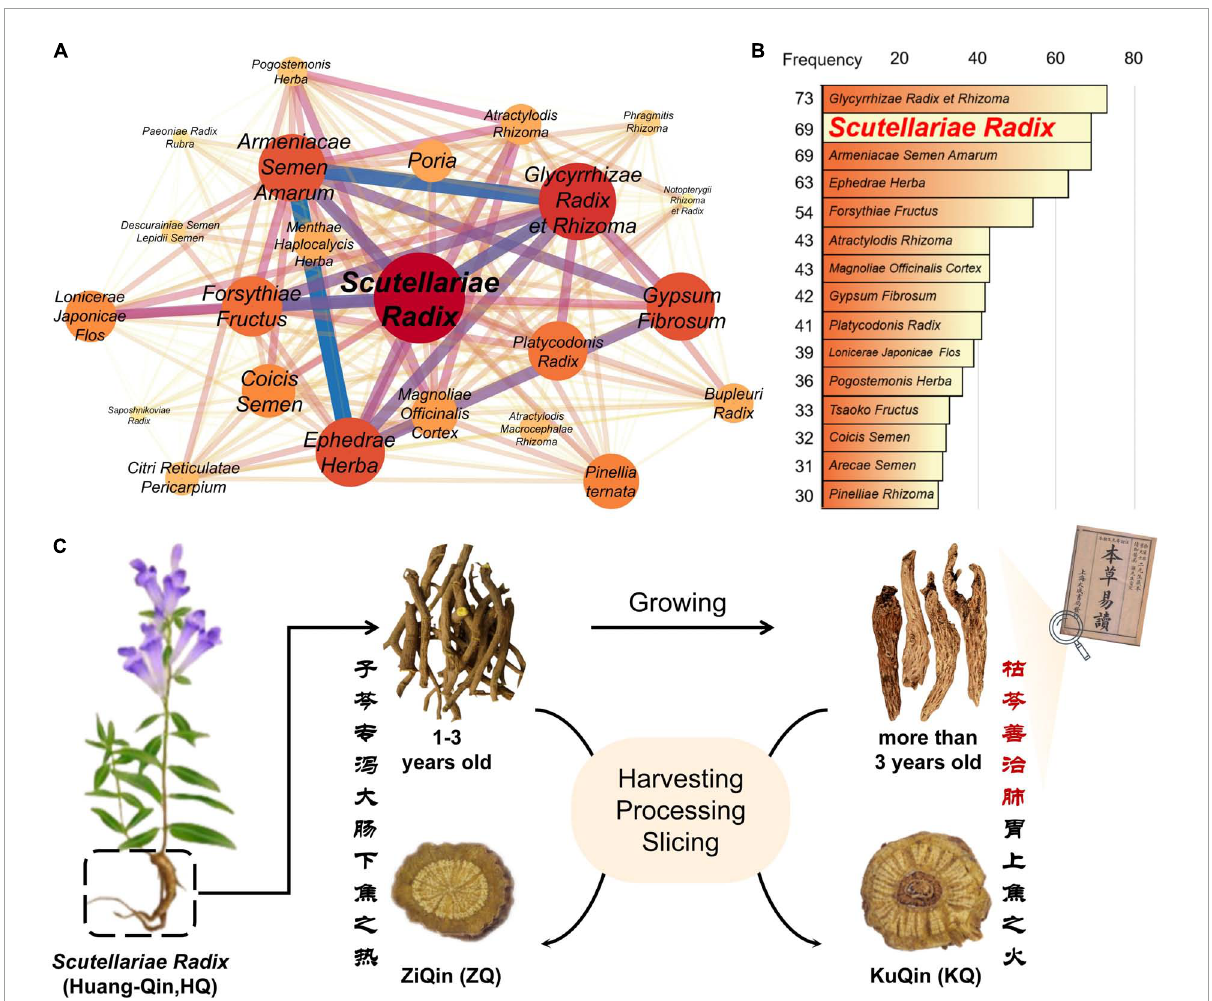
FIGURE1 (A) Analysis of the association rules of traditional Chinese herbal medicines used in adjuvant treatment of COVID-19. (B) Frequency analysis of single Chinese herbal medicine. (C) Schematic diagram of the source of ZiQin and KuQin. The classical Chinese shown in the picture means “400 years ago, ancient Chinese medicine books recorded that KuQin was good at cooling down the heat in the lung and stomach, and ZiQin was good at reducing the large-intestinal